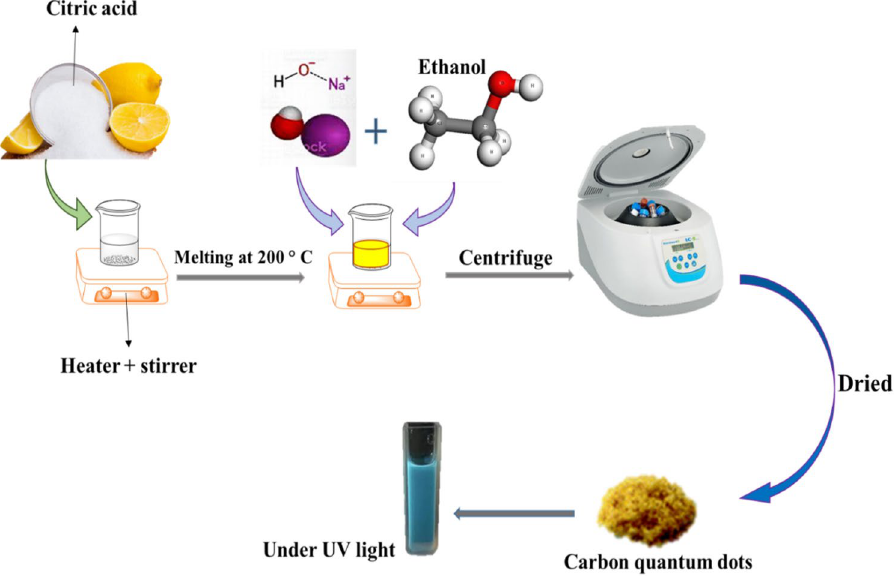
Figure 1. Synthesis of yellowish carbon quantum dots from citric